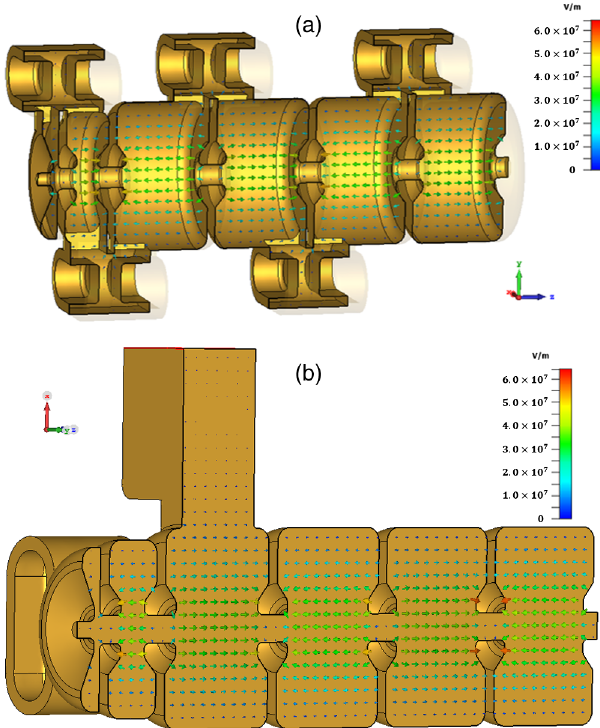
FIG. 15. Field profile of entire cavity generated in CST